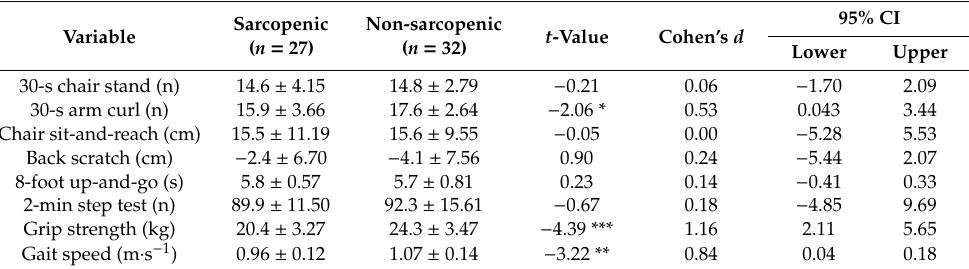
95% CI Lower Upper